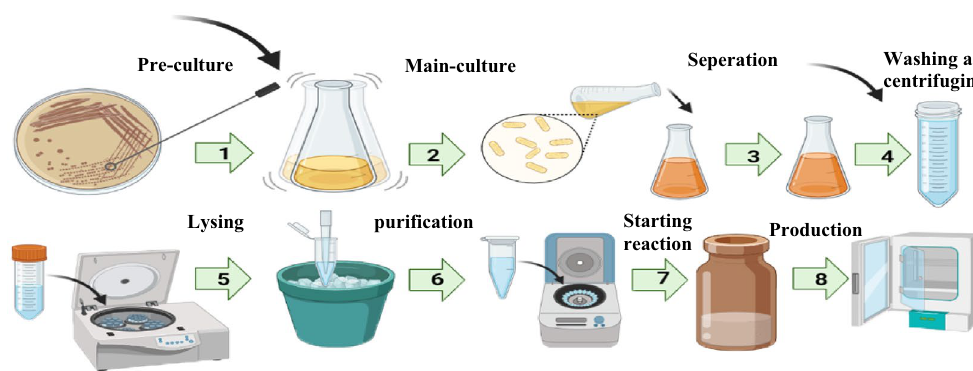
Figure 1. A schematic of bacterial lysis process and cell-free reaction. (1) inoculum from the bacterial plate to the Erlenmeyer flask which contains culture media to prepare pre-culture. (2) inoculum from overnight culture to some Erlenmeyer flask to reach high cell density for the lysis process. (3) transferring Erlenmeyer flask content to some falcon due to separating culture media from bacteria. (4) washing and centrifuging the pellets several times to remove all culture media. (5) lysing bacteria by a sonicator in an ice-water bath to prevent heat damage to bacteria. (6) centrifuging lysis solution to obtain supernatant which contains glycolytic pathway enzymes. (7) transferring bacterial extract to the reaction environment (glass vial) and adding substrate and necessary cofactors to initiate the cell-free reaction. (8) incubation of the glass vial for producing desired product in an incubator.